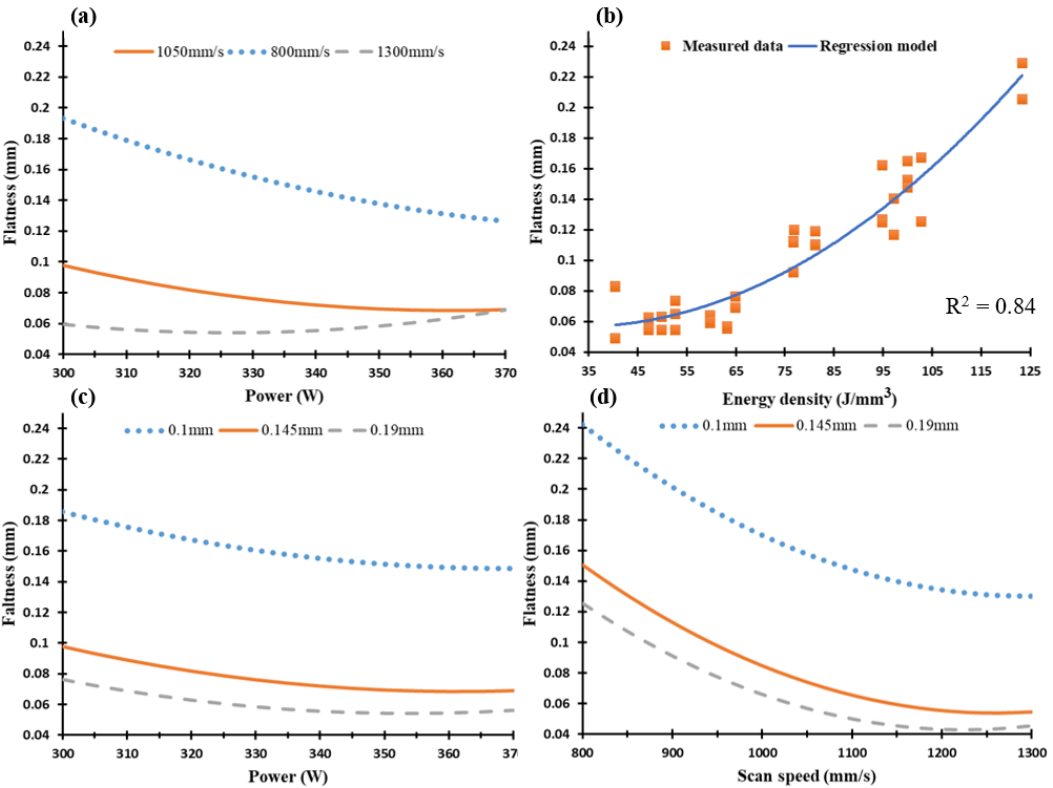
Figure 17. Surface flatness of the as-built Al6061 samples vs. ( a ) laser power (W), ( b ) eenergy density (J/mm 3 ), ( c ) hatch spacing (mm), and ( d ) scan speed